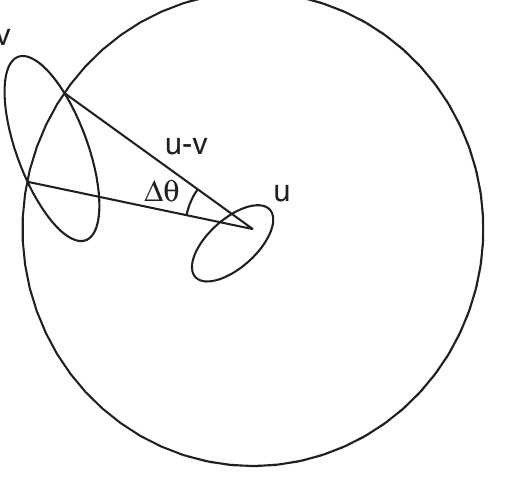
FIG. 2. Plan for (cid:13) integration. FIG. 3. Beam frame